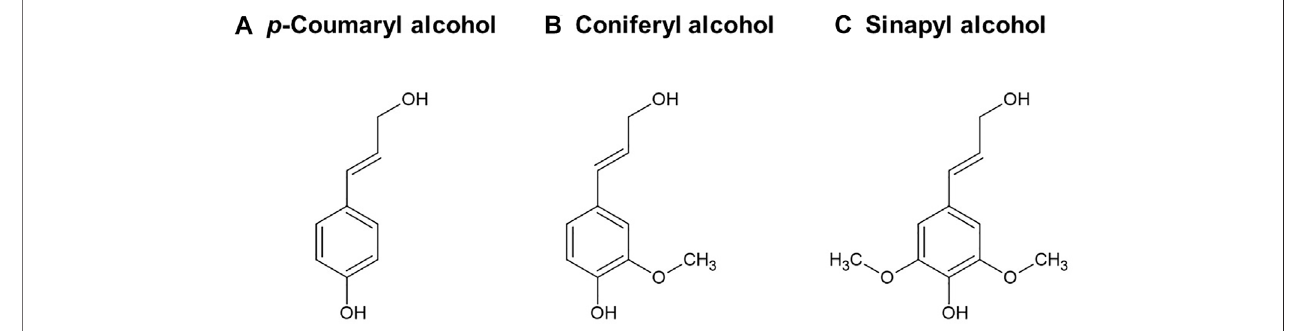
FIGURE 1 | Three monolignols of lignin heterogeneous structure. (A) p-Coumaryl alcohol, (B) Coniferyl alcohol, (C) Sinapyl alcohol.